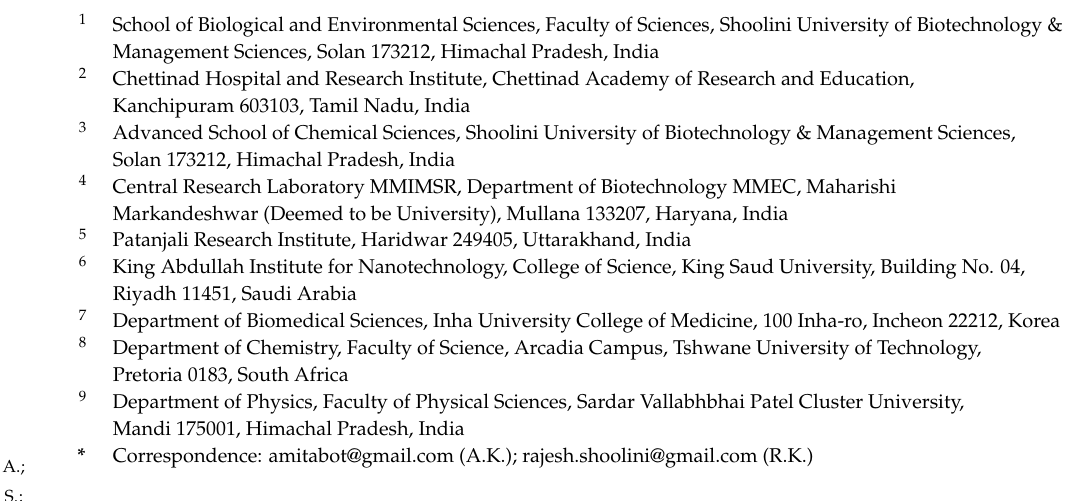
( b ) Figure 5. FE-SEM micrographs ( a ) and Elemental mapping ( b ) of ZnO-NPs.